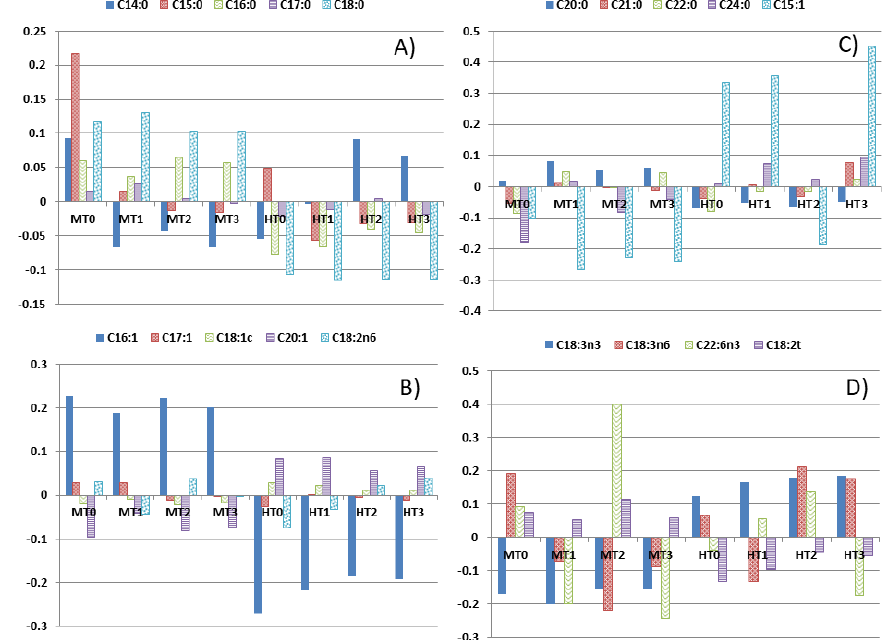
Figure 1. Geometric mean bar plots (relative to the overall geometric mean) for the green Spanish- style table olive according to cultivars and processing phases. ( A – D ) are for the study of different groups of the analysed fatty acids. M, Manzanilla; H, Hojiblanca; T0, fresh olives; T1, lye-treated olives; T2, fermented olives; T3, packaged olives. Treatments within cultivar are formed by combining cultivar and processing